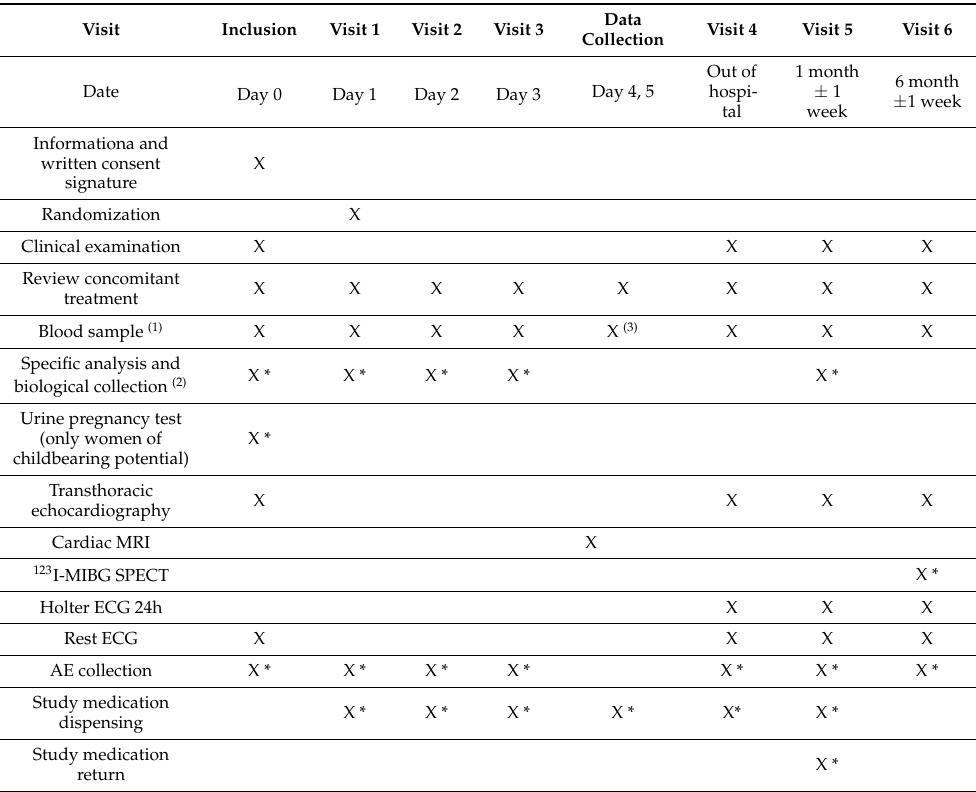
Table 1. Timetable of Visits and Procedures. MRI: Magnetic Resonance Imaging, ECG: Electrocardio- gram. AE: Adverse